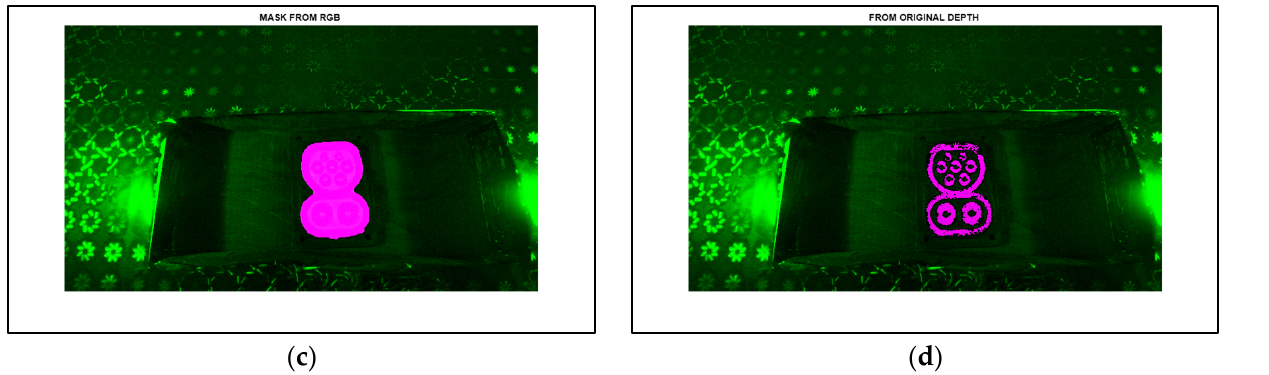
Figure 14. ( a ) Input RGB image, ( b ) result of the intensity transformation, ( c ) obtained binary mask, and ( d ) detected CCS2 connector.